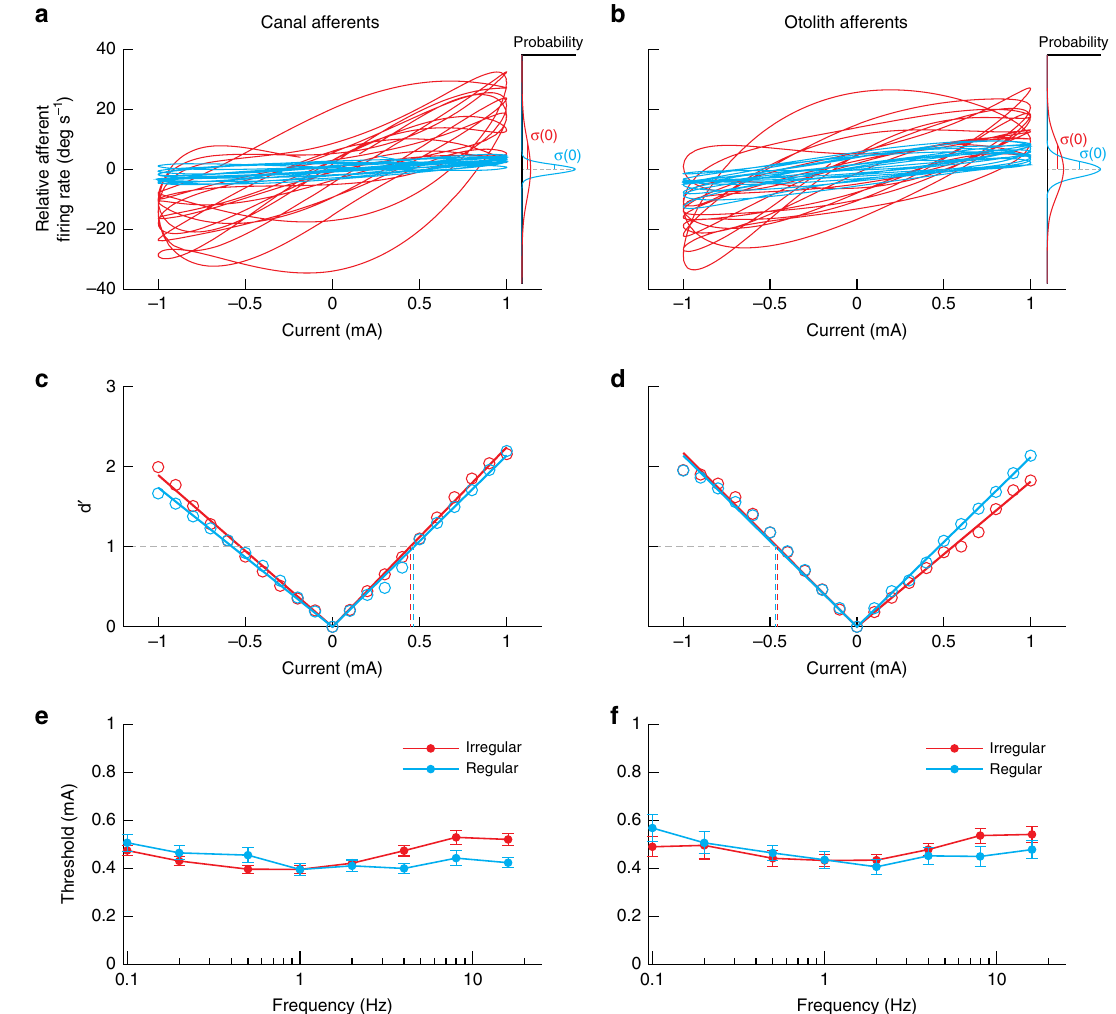
Fig. 8 Detection thresholds for regular and irregular canal and otolith afferents during 1 Hz sinusoidal GVS. a , b Firing rate plotted as a function of stimulus current for regular (blue) and irregular (red) canal and otolith afferents. c , d Signal detection theory was used to compare the distribution of fi ring rates for a given value of stimulus current and that obtained for zero current (see insets in a , b ) to obtain a plot of d ′ as a function of stimulus current. The detection threshold T d´ was computed as the lowest absolute value of stimulus current for which d ’ = 1 (dashed horizontal gray lines). e , f Population-averaged detection threshold values T d´ for regular (blue) and irregular (red) canal and otolith afferents as a function of frequency. Neuronal detection thresholds varied with GVS frequency for all afferent types (linear mixed model: p < 0.001), but remained relatively unchanged across fi ring rate regularity and end organ innervation (Student t -tests: p > 0.00625 Bonferroni ’ s correction for multiple comparisons). Error bars depict the